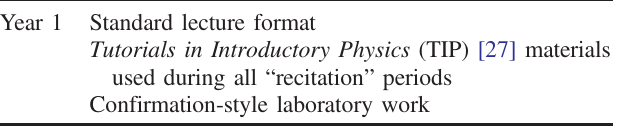
TABLE VI. Changes that were made each year to the general physics course at school